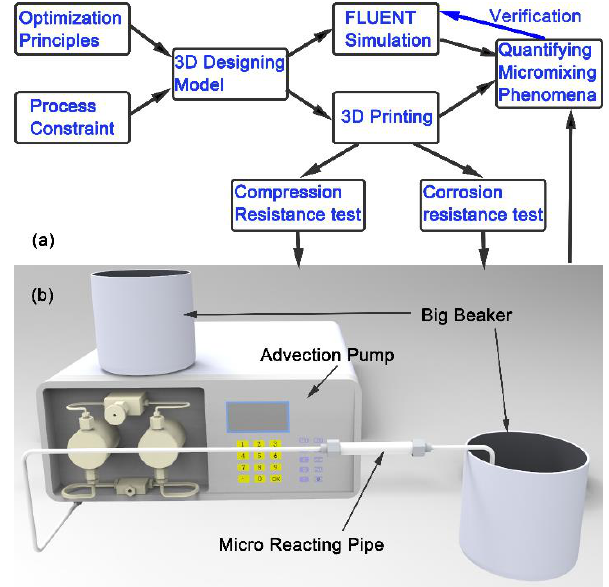
Figure 2. The flow chart of the research: ( a ) overall process; ( b ) test platform model.